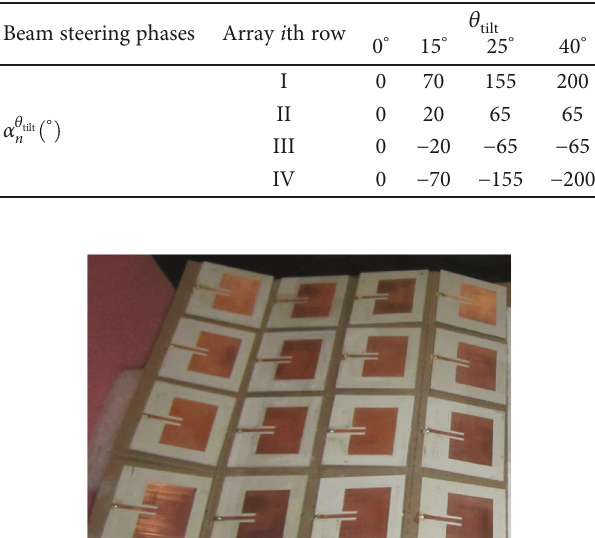
Table 1: Beam steering phases.